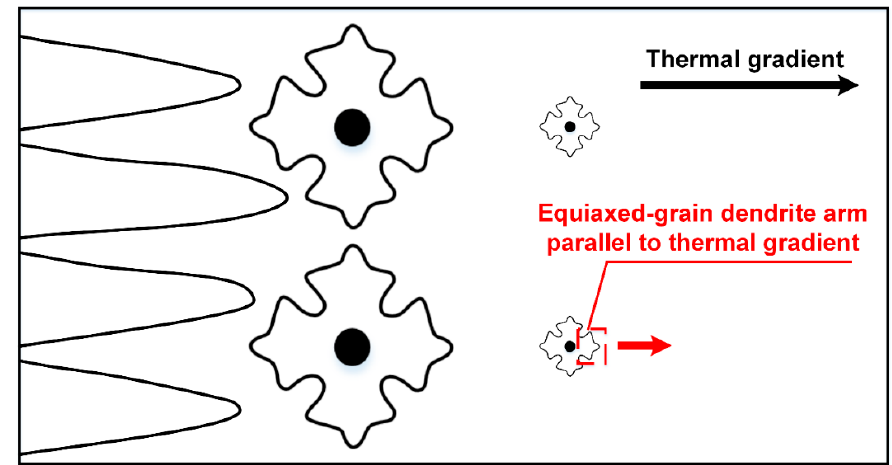
Figure 17. The diagram of second row of nuclei.